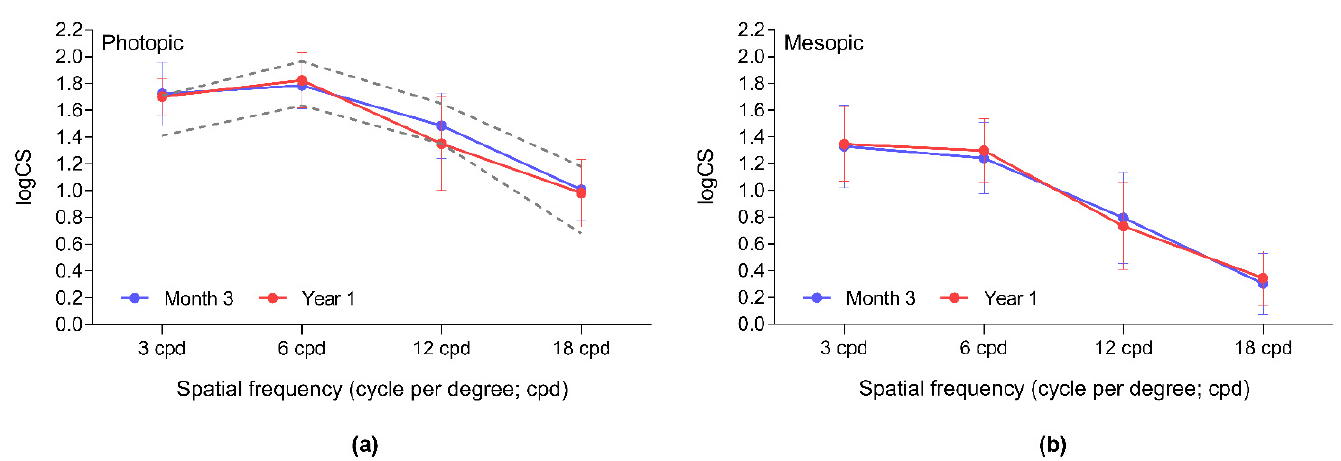
Figure 6. Photopic ( a ) and mesopic ( b ) contrast sensitivity is stable during the first postoperative year. Results are within the age-defined population normal values for the older age group (50–75 years of age) [17]. logCS: logarithm of Contrast Sensitivity; cpd: Cycle per degree.